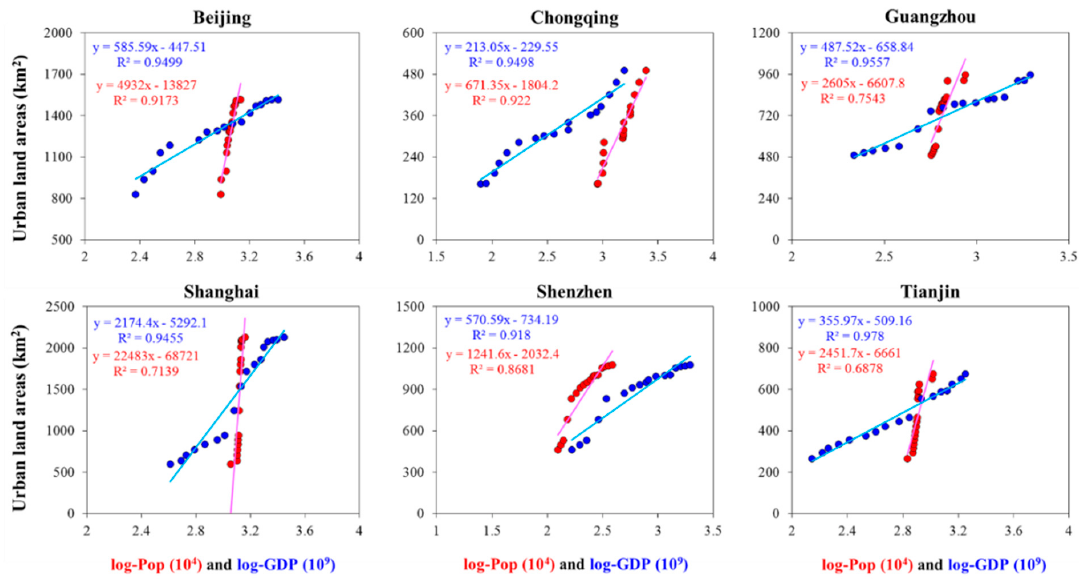
Figure 7. Relationships between urban land expansion and population and GDP growth.